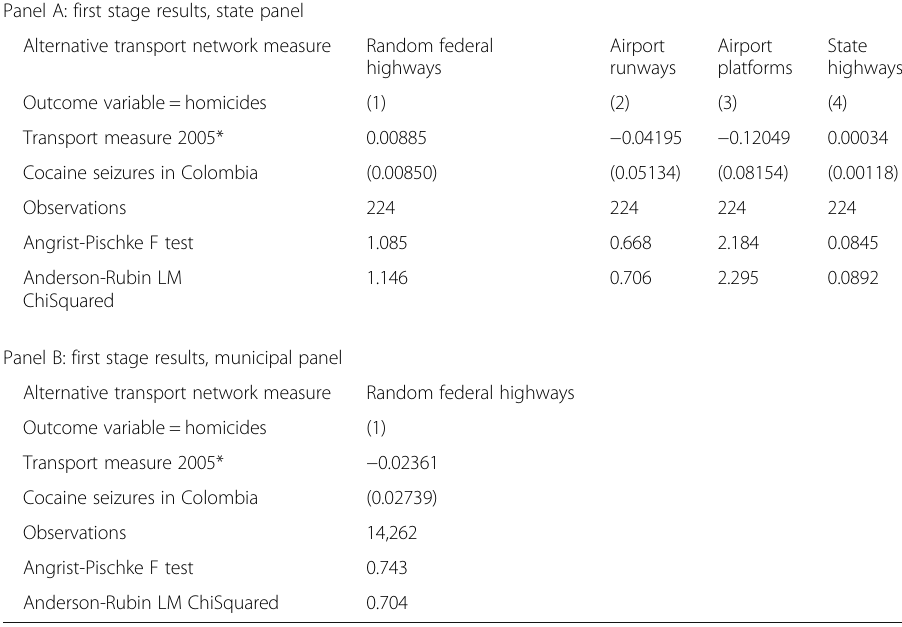
Panel A: first stage results, state panel Alternative transport network measure